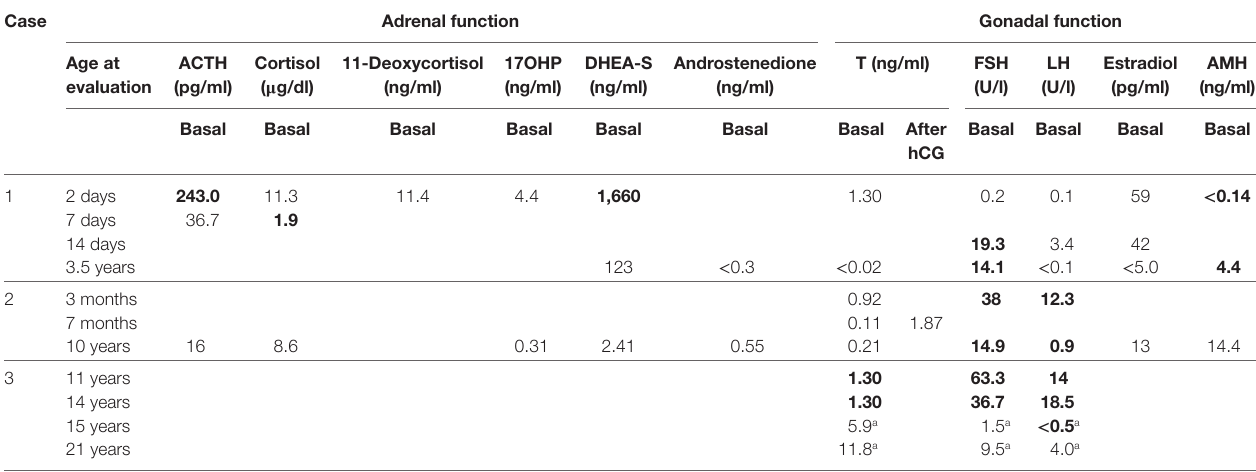
TaBle 2 | Biochemical characterization of three 46,XY DSD patients harboring variants in the GATA4 gene.